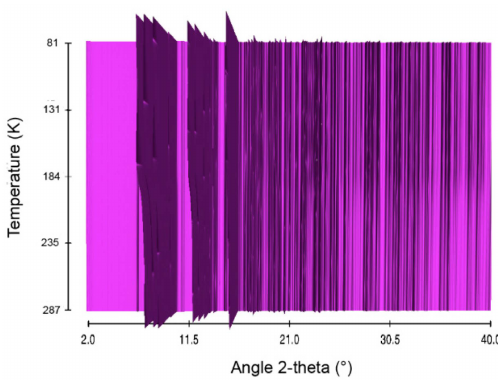
Figure 9. Sequential plot of the diffraction patterns of NaHB within the range of temperature 81–287 K. Like for LiHB, the unit cell parameters of NaHB exhibit a positive evolution (Figure 10) and the unit cell volume presents a normal evolution with positive coefficient of thermal expansion (Figure S17). The unit cell volume variation is not linear, which is consistent with an anisotropic expansion. The coefficient of thermal expansion was found to be 10.31 ˆ 10 ´ 5 K ´ 1 (Table 2), which is similar to the coefficient found for